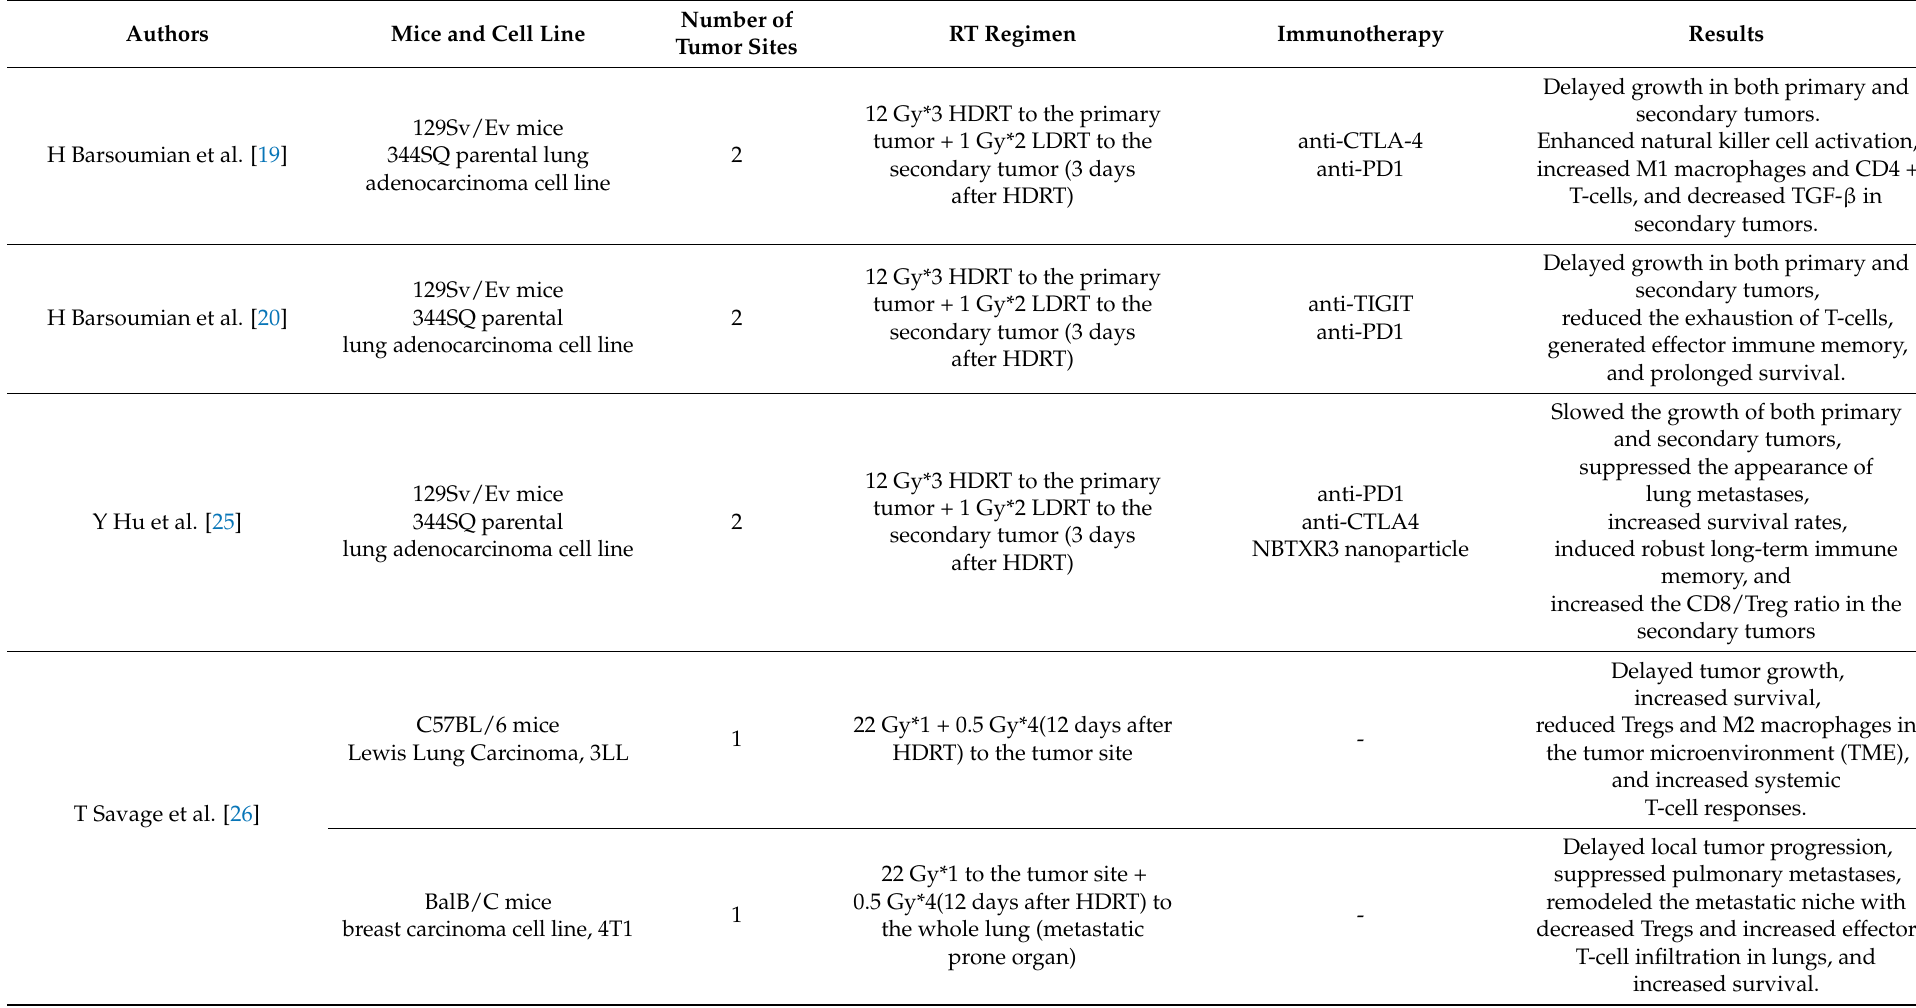
Table 1. Key preclinical studies on evaluating the valuating immune effect of high-dose radiotherapy (HDRT) + low-dose radiotherapy